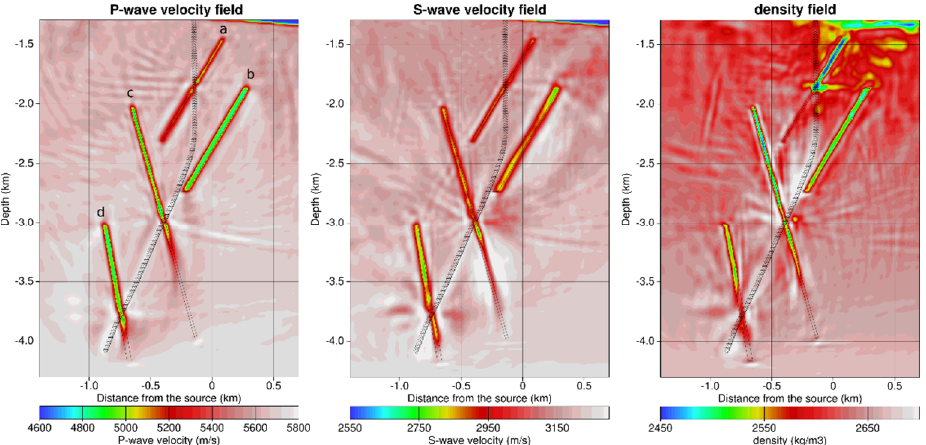
Figure 15. P- and S-wave velocity and density estimated fields from experiment with several faults having different features. The features of the modelled faults are shown in Table 3. The inverted triangles showed the receivers in the deviated well. We show the results only around the faults. The black polygon shows the location of the true modelled faults.